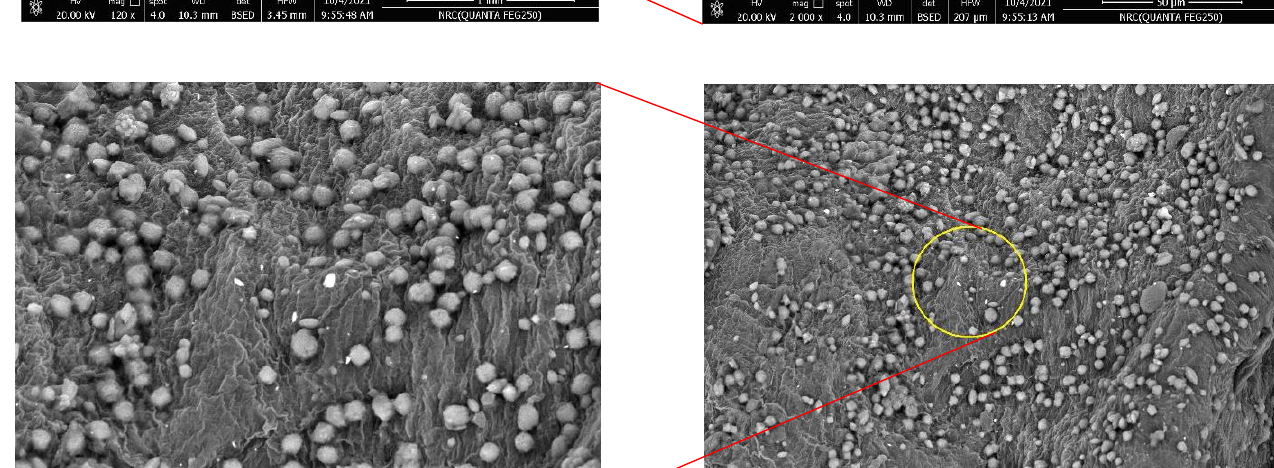
Figure 7. SEM image with different magnification for nanocellulose/chitosan microbead (CCMB- 0.25:1).